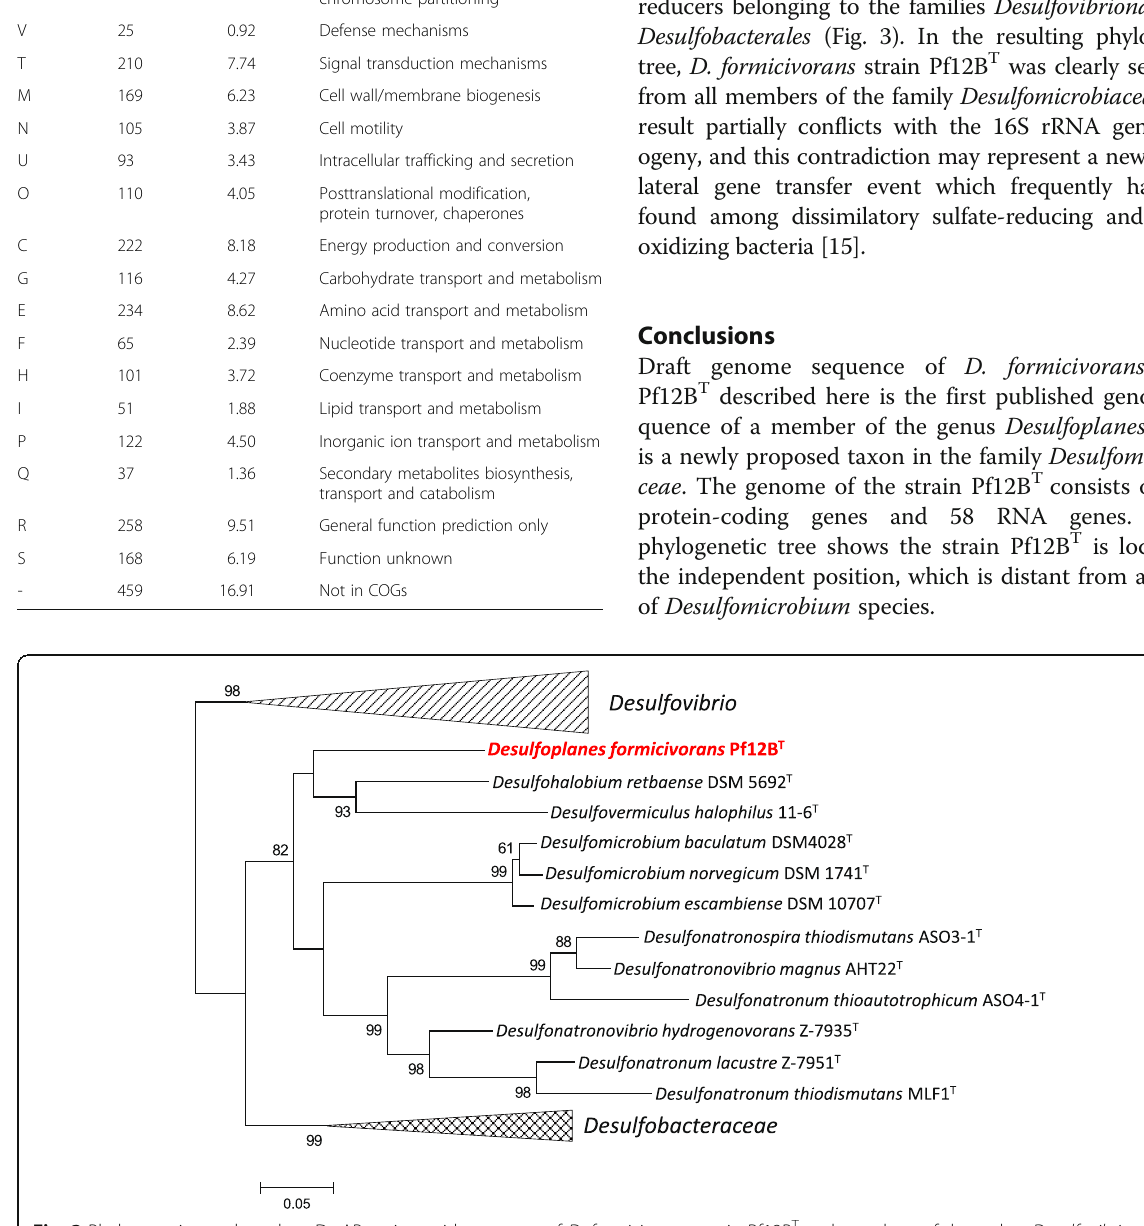
Fig. 3 Phylogenetic tree based on DsrAB amino acid sequence of D. formicivorans strain Pf12B T and members of the orders Desulfovibrionales and Desulfobacterales . The tree was constructed by the Maximum-Likelihood method with MEGA version 5.1 [16] based on ClustalX version 2.1 [17] aligned protein sequences. Bootstrap values (percentages of 1000 replications) of ≥ 50% are shown at